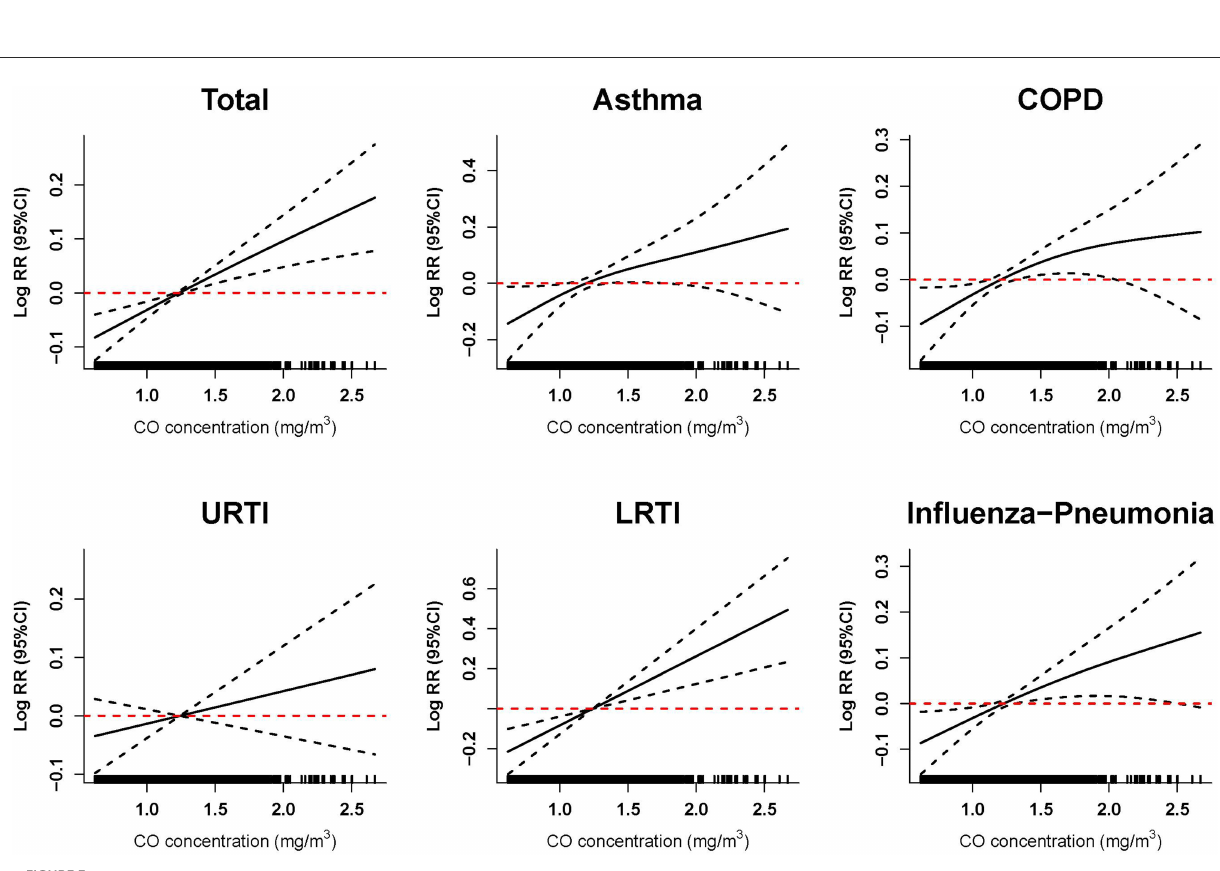
FIGURE3 Exposure–response relationship between ambient carbon monoxide and hospitalization risk for respiratory diseases. The vertical scale of the exposure–response curves can be interpreted as the log-relative change from the mean effect of carbon monoxide on the risk of hospitalization. The solid line represents the mean estimate, and the dashed lines represent the 95% confidence intervals. Exposure–response curves were performed at lag0–2 of ambient CO concentration for total and specific respiratory diseases. Models were adjusted for long-term and seasonal trends, temperature, relative humidity, public holiday, and DOW (day of the